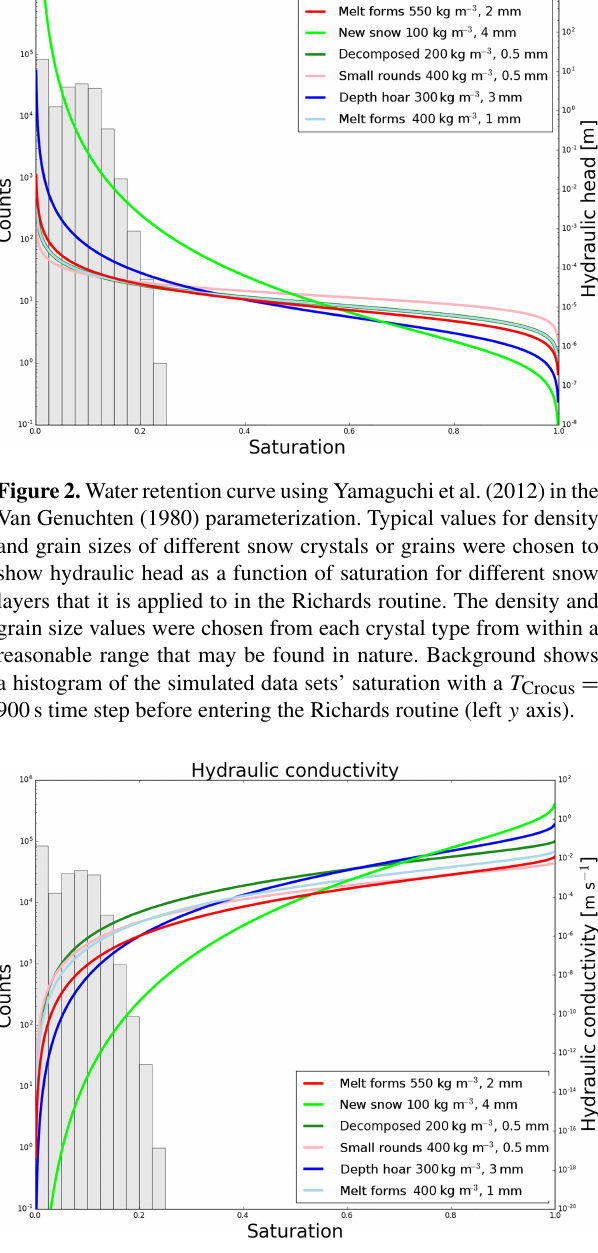
Figure 3. Hydraulic conductivity curve derived from Calonne et al. (2012) using Yamaguchi et al. (2012) parameters. Typical val- ues for density and grain sizes of different snow crystals or grains were chosen to show the hydraulic conductivity for the spectrum of different snow layers that it is applied to in the Richards routine. The density and grain size values were chosen from each crystal type from within a reasonable range that may be found in nature. Background shows a histogram of the simulated data sets’ satura- tion with a T Crocus = 900s time step before entering the Richards routine (left y